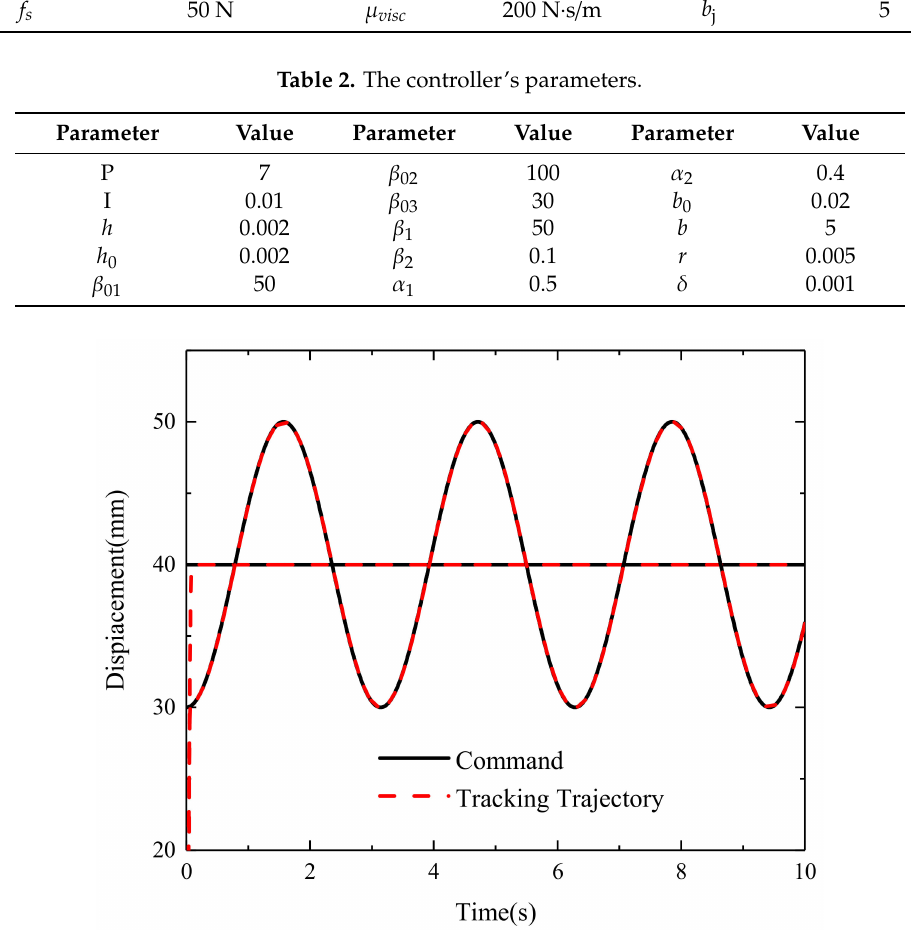
Figure 8. Step and sinusoidal tracking